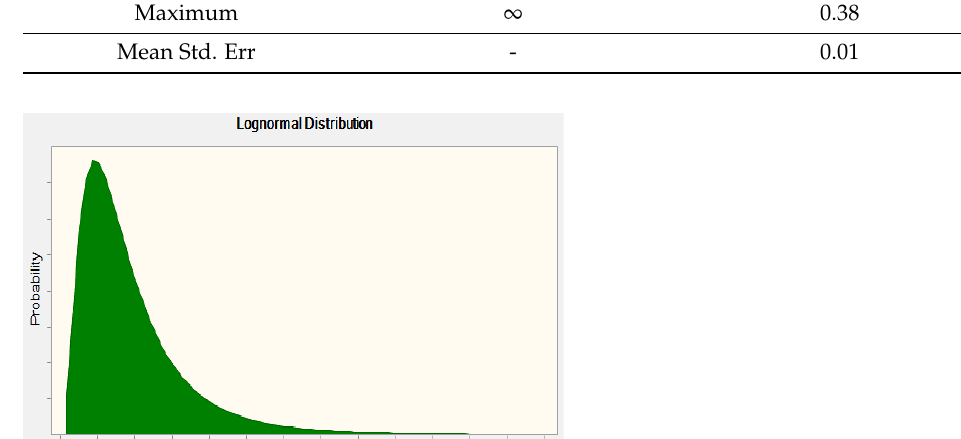
Figure 1. Probability distribution of accommodation facilities’ occupancy in Bratislava during 2003–2019.